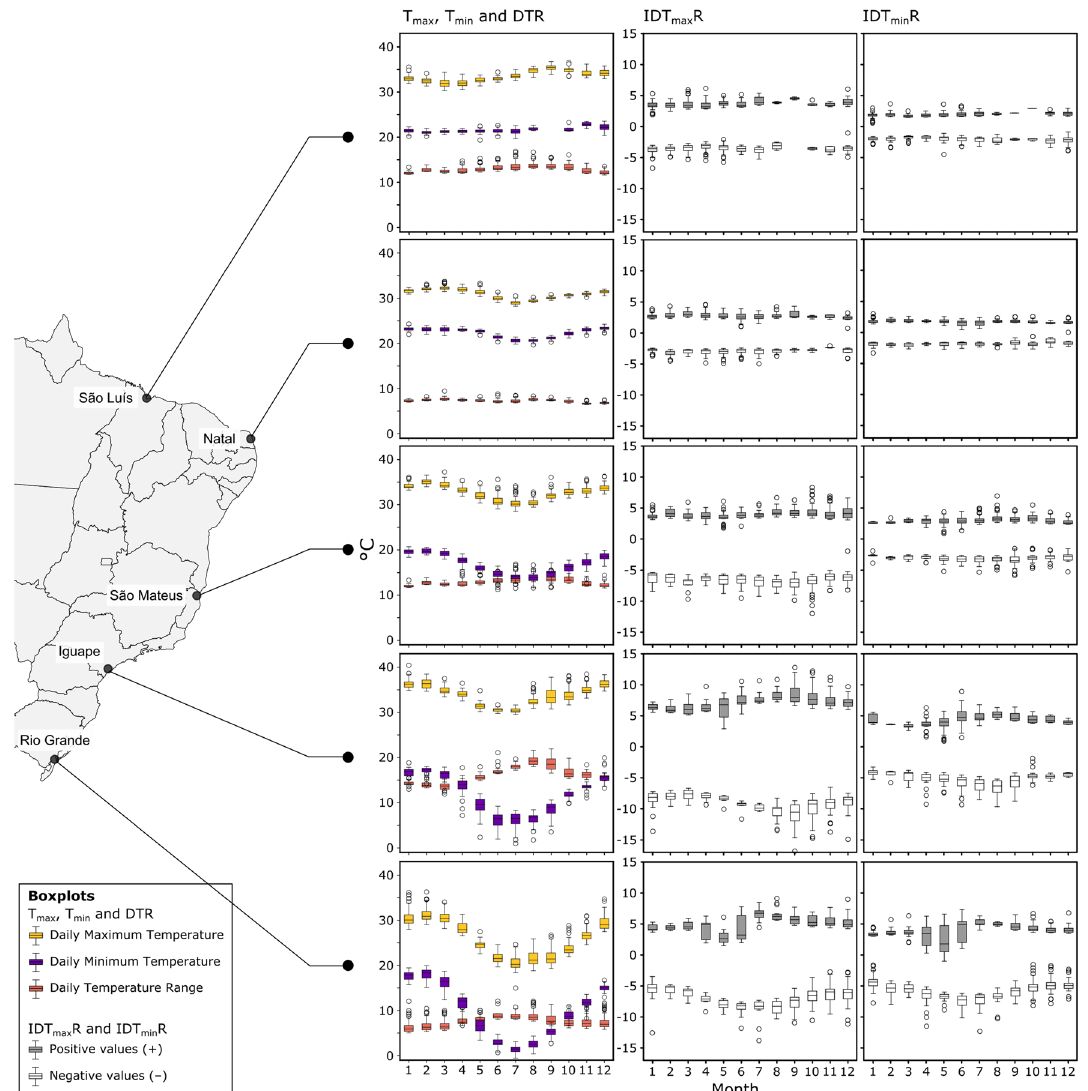
Figure 5. Overall monthly overview of temperatures considered extremes from all 5 MEOW in the last 40 years. The results are presented to the following response variables: daily maximum temperatures (T max ); daily minimum temperatures (T min ); daily temperature range (DTR); positive inter-daily T max range (+ IDT max R); positive inter-daily T min range (+ IDT min R); negative inter-daily T max range (− IDT max R); and negative inter-daily T min range (− IDT min